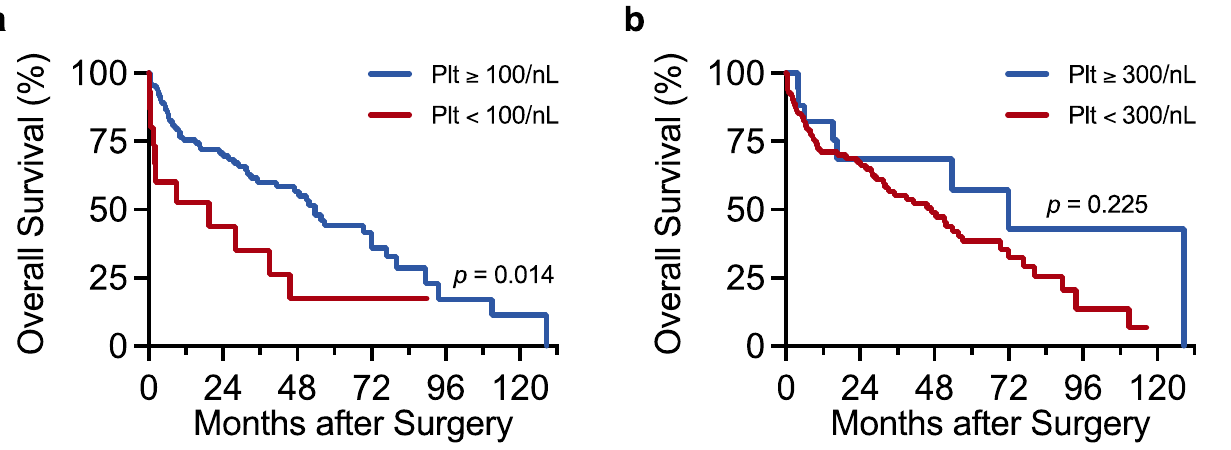
Figure 3. Low platelet count associates with reduced overall survival in resectable HCC. ( a , b ) Kaplan–Meier plots showing the association of platelet count (Plt) with overall survival. Overall survival was compared between patients with platelet counts ≥ 100/nL ( n = 113) and <100/nL ( n = 15) in ( a ) and between those with counts ≥ 300/nL ( n = 17) and <300/nL ( n = 111) in ( b ). Survival data were modelled by Cox regression analysis. Results with a p -value < 0.05 were considered statistically significant.